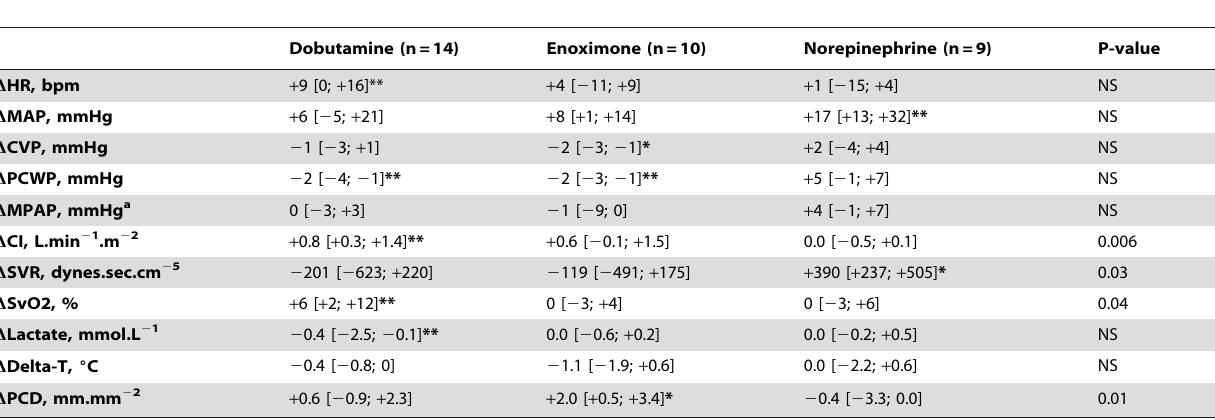
Table 3. The effects of infusions of dobutamine (median 60 minutes), enoximone (median 85 minutes), and norepinephrine (median 75 minutes) on parameters of macro- and microcirculation.